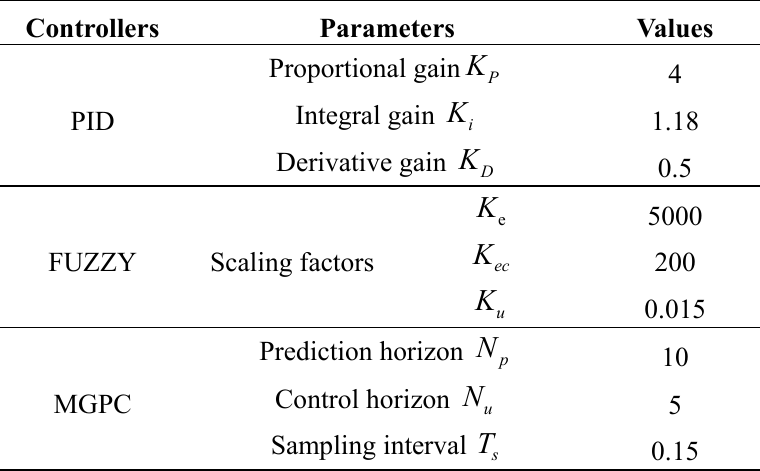
Table A2. Parameters of